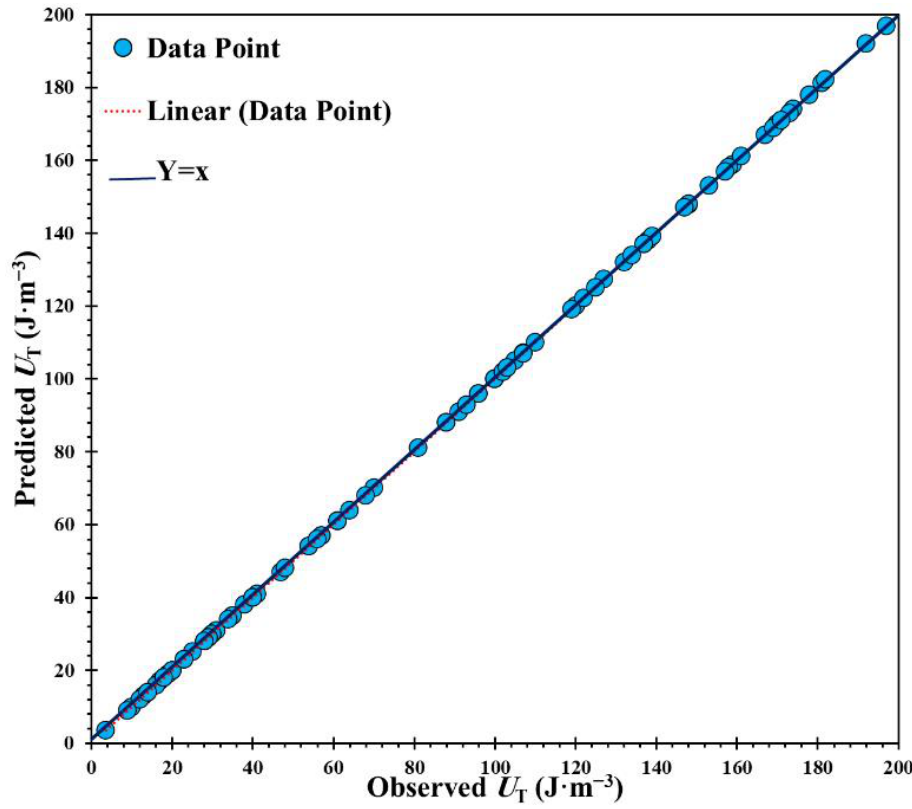
Figure 6. Optimized ANFIS model obtained by removing non-sensitive parameters.